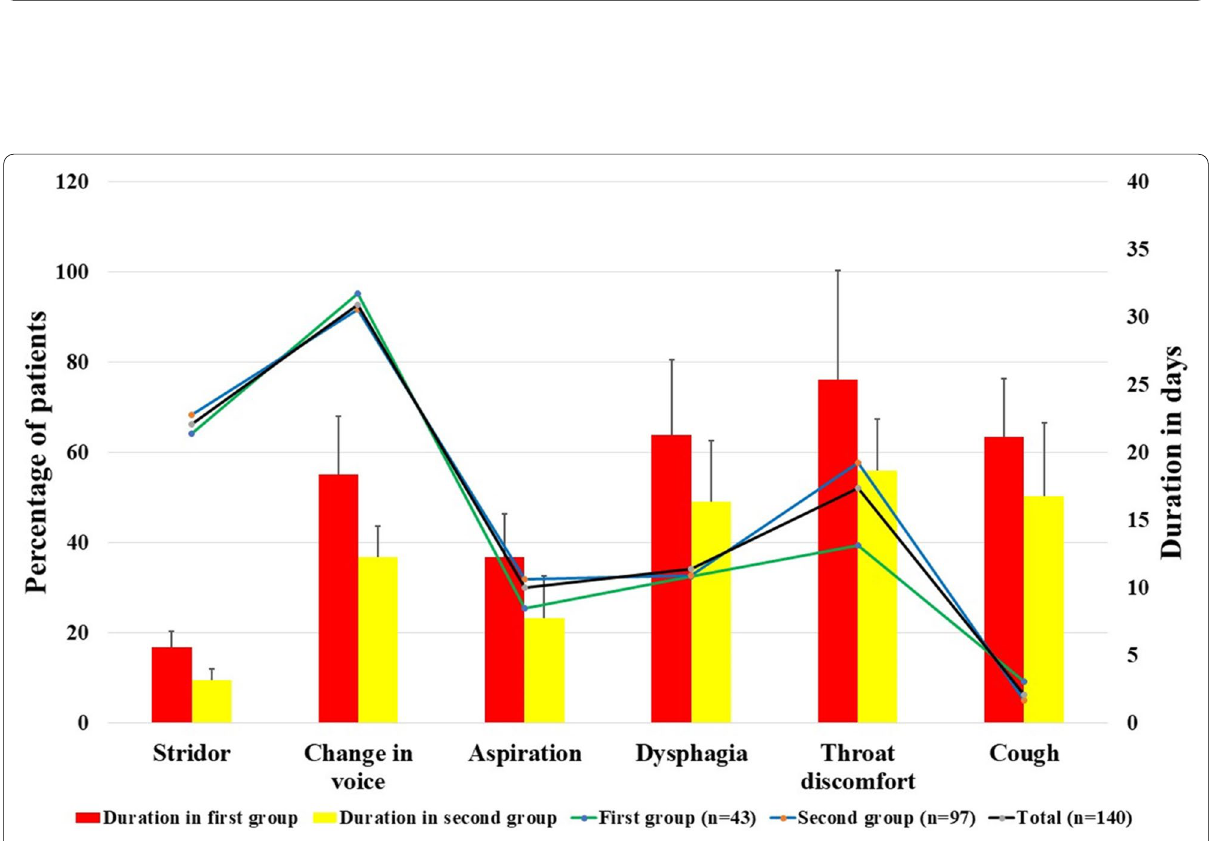
Fig. 2 Presenting features and duration of onset (with their SD) in